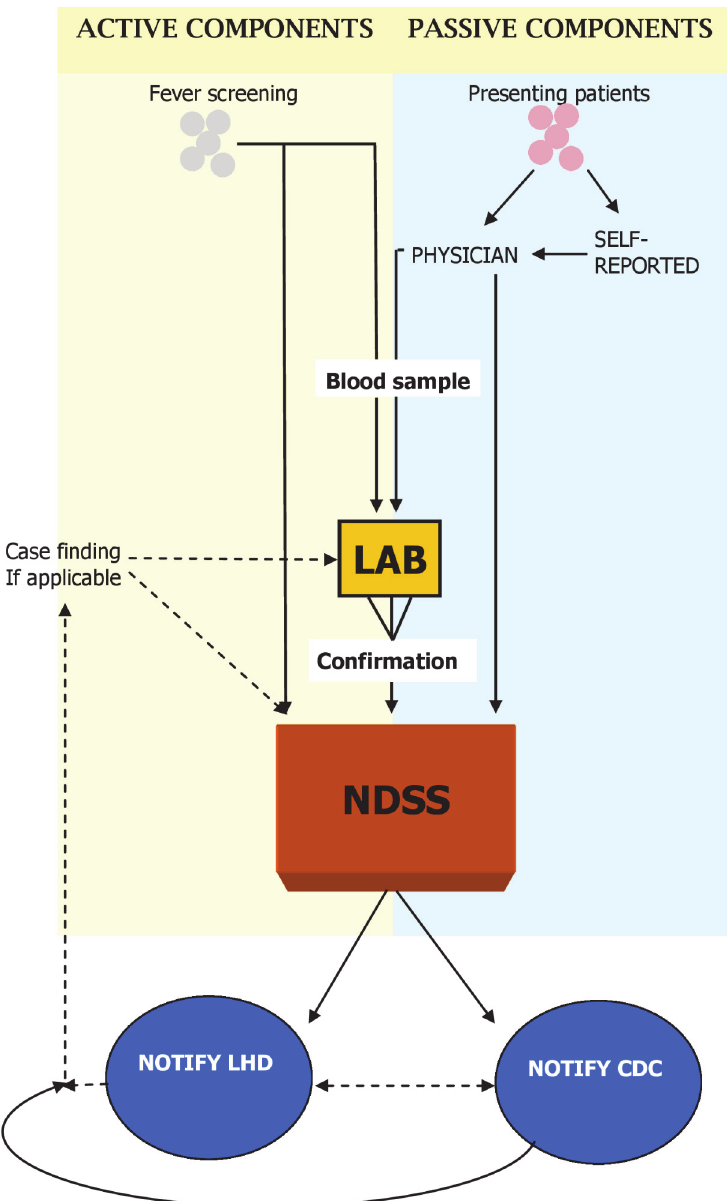
Fig 1. Flow chart of data flows within the National Disease Surveillance System (NDSS) for dengue fever in Taiwan.